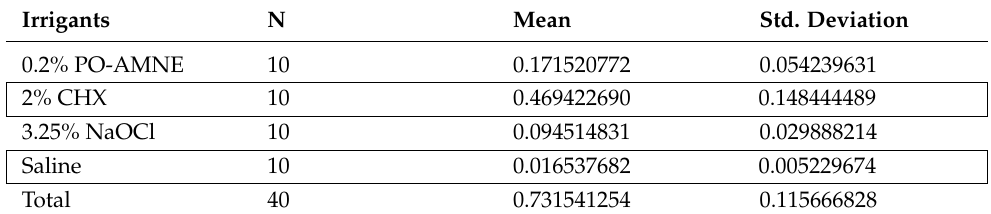
Table 10. Mean and standard deviation of irrigants against S. epidermidis at 400 µ m. Irrigants N Mean Std. Deviation